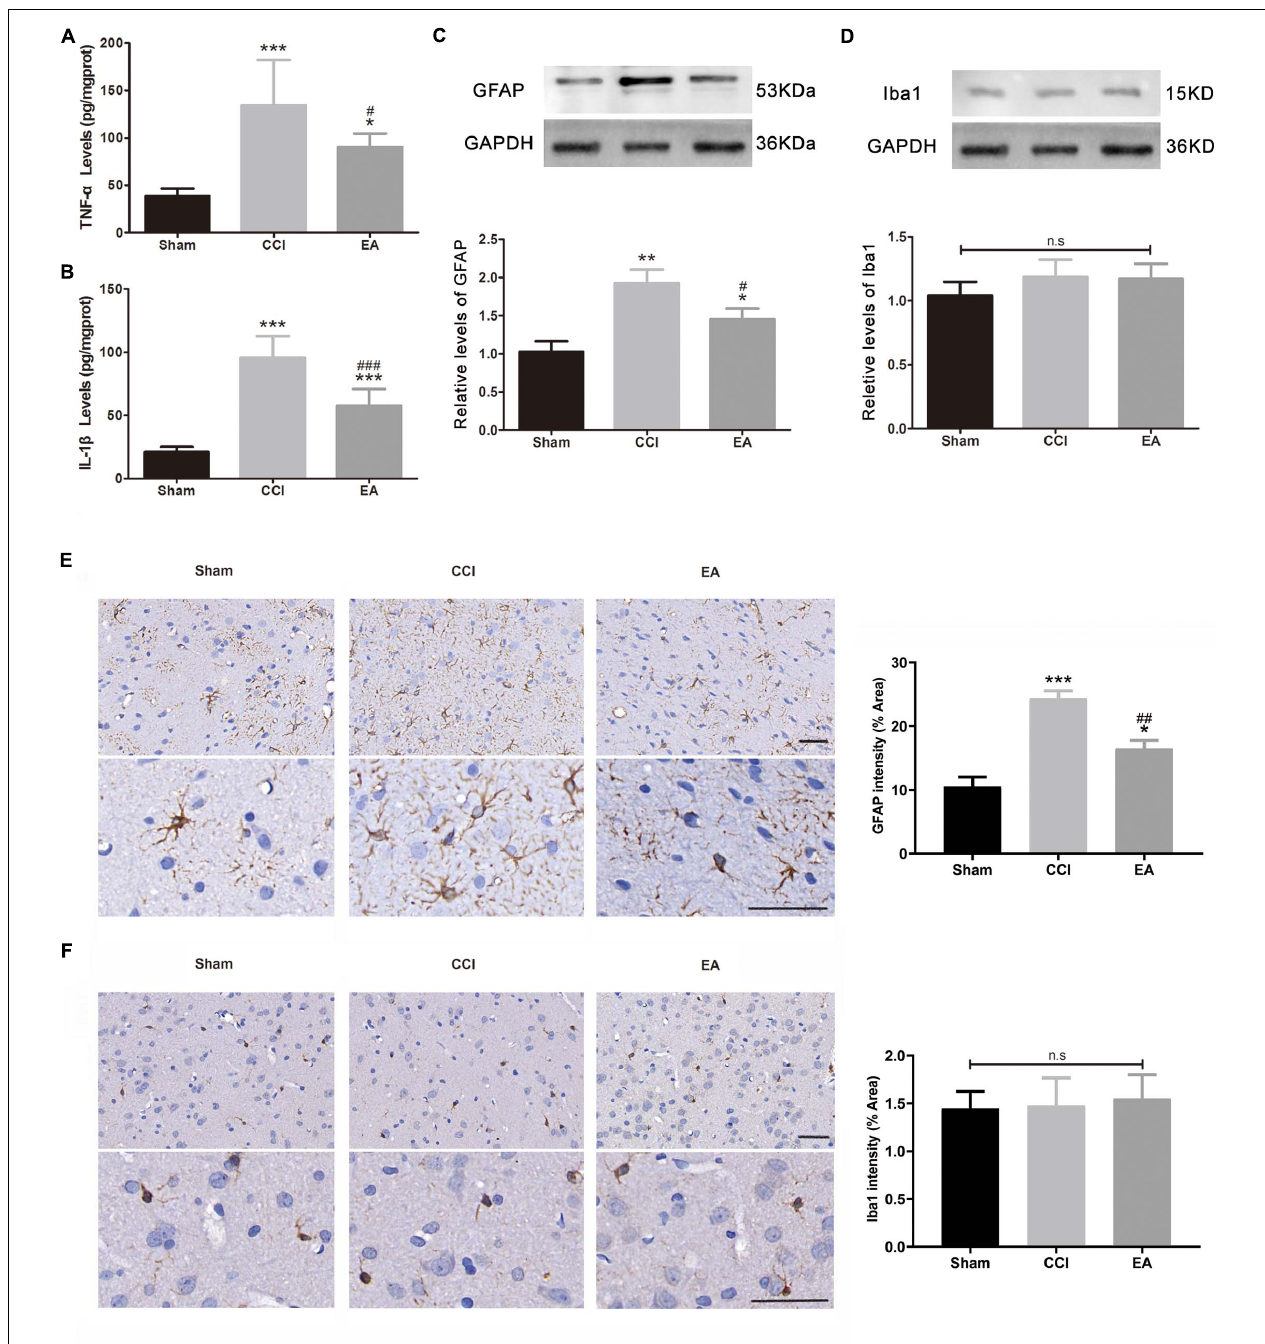
FIGURE 3 | The effects of EA on neuroinflammation in the amygdala. The concentration of TNF α (A) and IL-1 β (B) was analyzed using enzyme-linked immunosorbent assay (ELISA) ( n = 6 per group). The protein levels of glial fibrillary acid protein (GFAP, C ) and Iba-1 (D) were analyzed using western blotting, while the (C,D) used the same loading control (GAPDH) ( n = 3 per group). Representative immunohistochemistry staining images and signal intensity quantitation of GFAP (E) and Iba-1 (F) are shown (scale bar = 50 µ m) ( n = 4 per group). Results are expressed as the mean ± SEM. * p < 0.05, ** p < 0.01, *** p < 0.001 vs. the sham group; # p < 0.05, ## p < 0.01, ### p < 0.001 vs. the CCI group. The “n.s” means no statistical differences were observed among three groups.